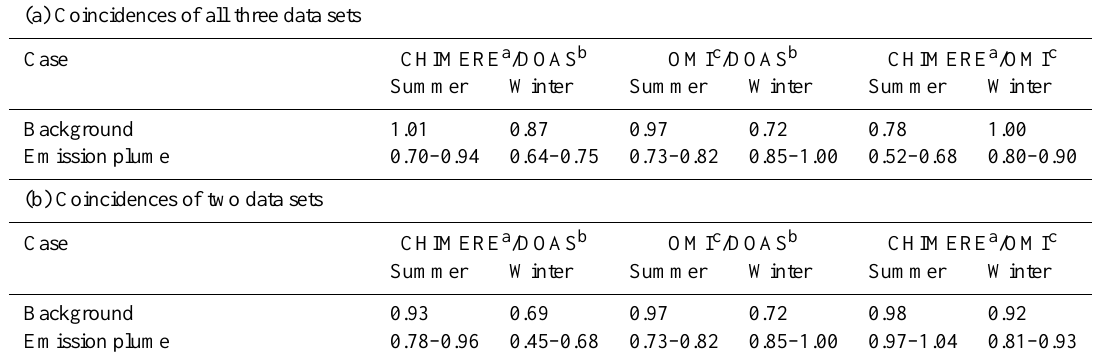
Table 5. Summary of the quantitative comparisons between the three data sets for different data selections. The background results are derived from the ratios of the daily averages. The results for the emission plumes are derived from the ratios of the daily maximum values and the correlation analyses of the individual observations. Note that for both data selections the results for the comparison between OMI and car-MAX-DOAS are the same, because CHIMERE data are available for all